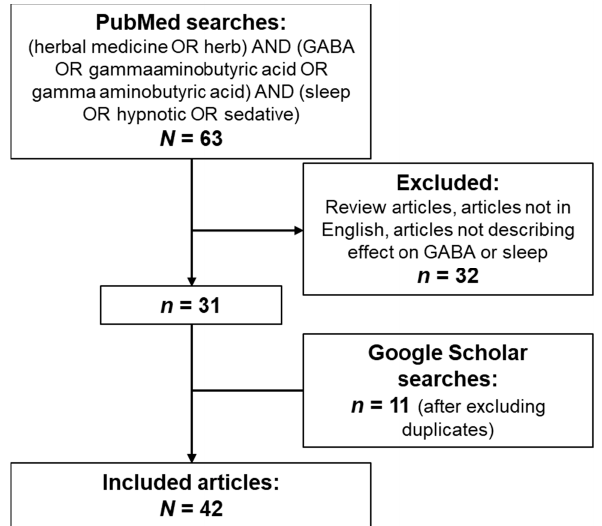
Figure 4. PRISMA flow diagram. GABA, gamma-aminobutyric acid; PRISMA, preferred reporting items for systematic reviews and meta-analyses.